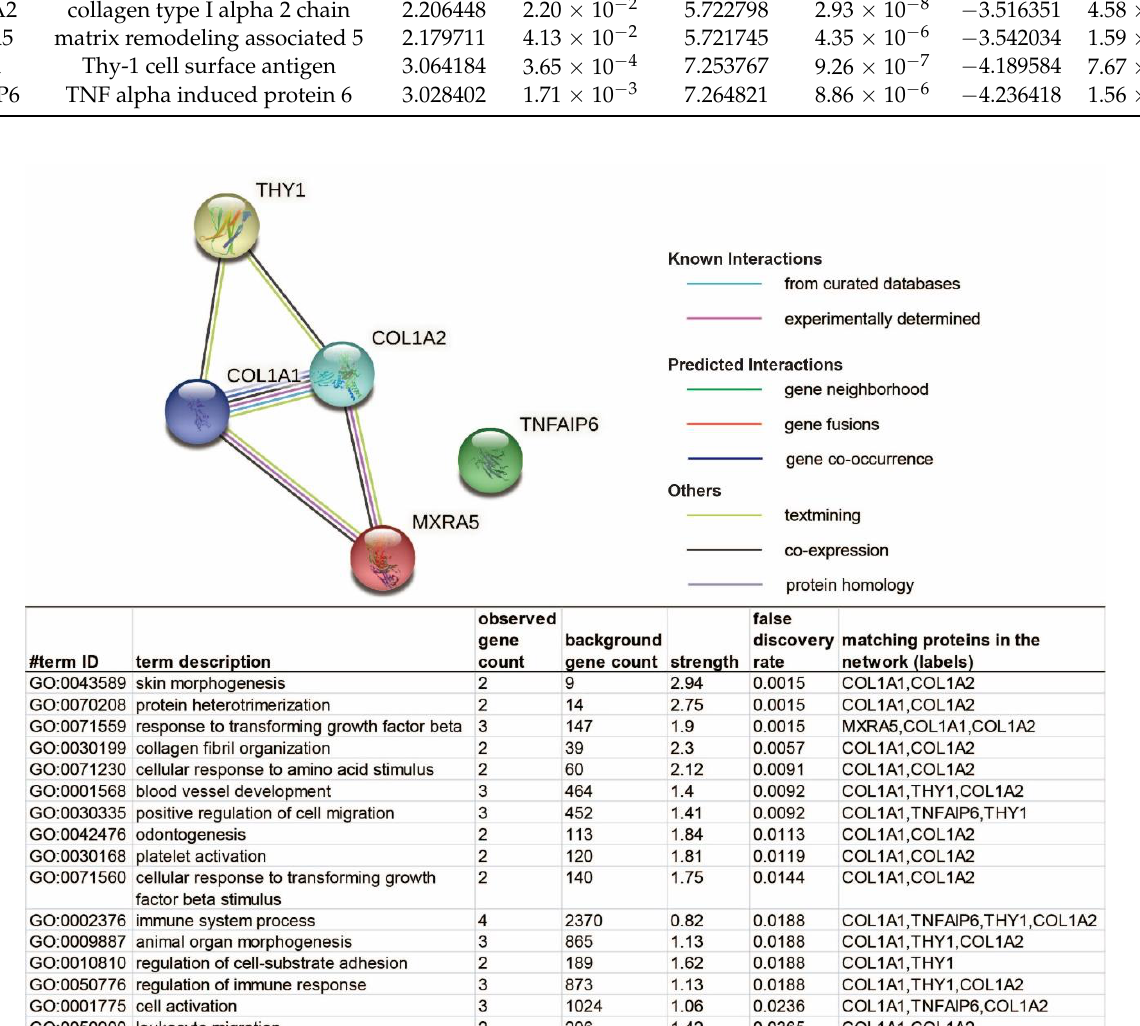
Figure 5. The STRING server displayed the protein–protein interaction network among the five common OA-responsive DEGs, which have significantly different multiples of change in male and female cartilage. The network nodes represent proteins, while filled nodes are for the proteins with known or predicted 3D structures. Edges represent protein–protein associations. The list contains identified pathways with a false discovery rate (FDR) of less than 0.05.